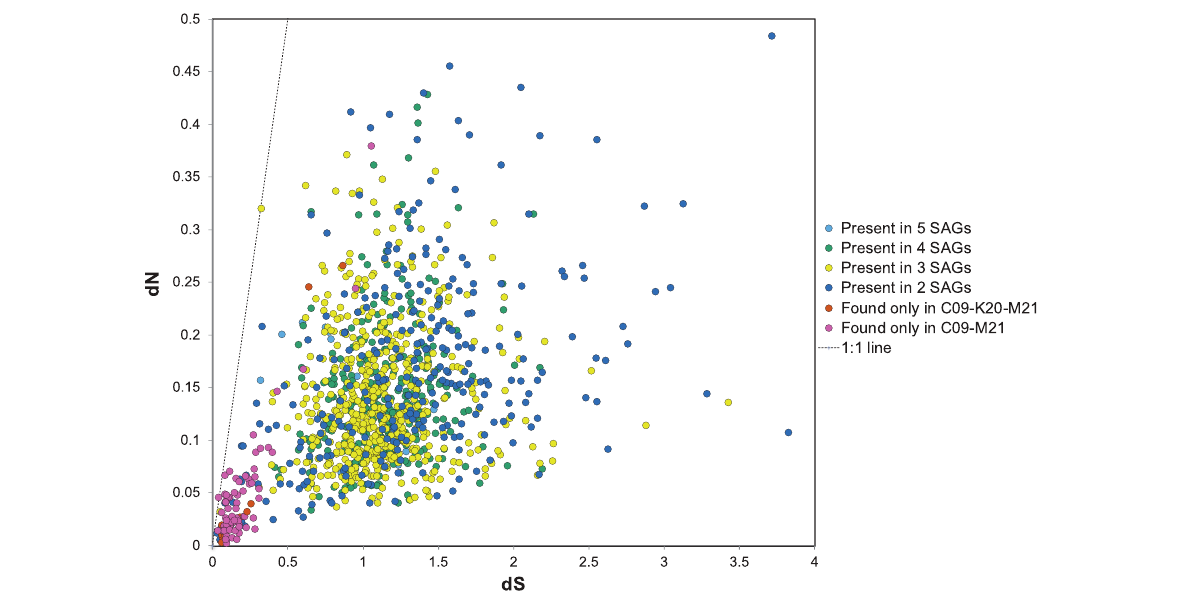
FIGURE 5 | dN relative to dS for open reading frame (ORF) clusters. The dots in orange or pink represent ORFs shared between C09/M21 or C09/M21/K20, which includes the nitrogenase island of genes. Clusters of genes found in single genomes are excluded from this plot. The dotted line represents dN/dS =